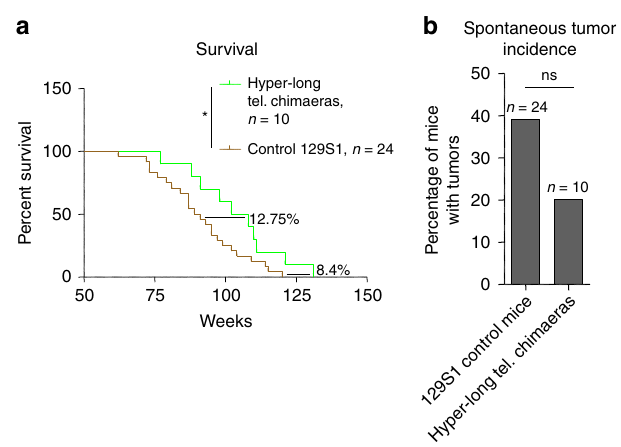
Fig. 4 Hyper-long telomere mice live longer and have less spontaneous cancer. a Survival proportions of 100% hyper-long chimeric mice compared to control mice from the same background. Hyper-long telomere mice show a 12.75% increase in median lifespan and an 8.4% increase in maximum lifespan. b Quanti fi cation of spontaneous tumor incidence in hyper-long telomere mice and controls. Hyper-long telomere mice show a decrease in almost 20% in tumor incidence compared to control mice from the same background. Error bars represent standard error. Mantel – Cox test was used for statistical analysis in survival curves and Chi-square test for spontaneous tumor incidence. The number of mice is indicated in each case. * p < 0.05. ** p < 0.01. *** p < 0.001. Source data are provided as